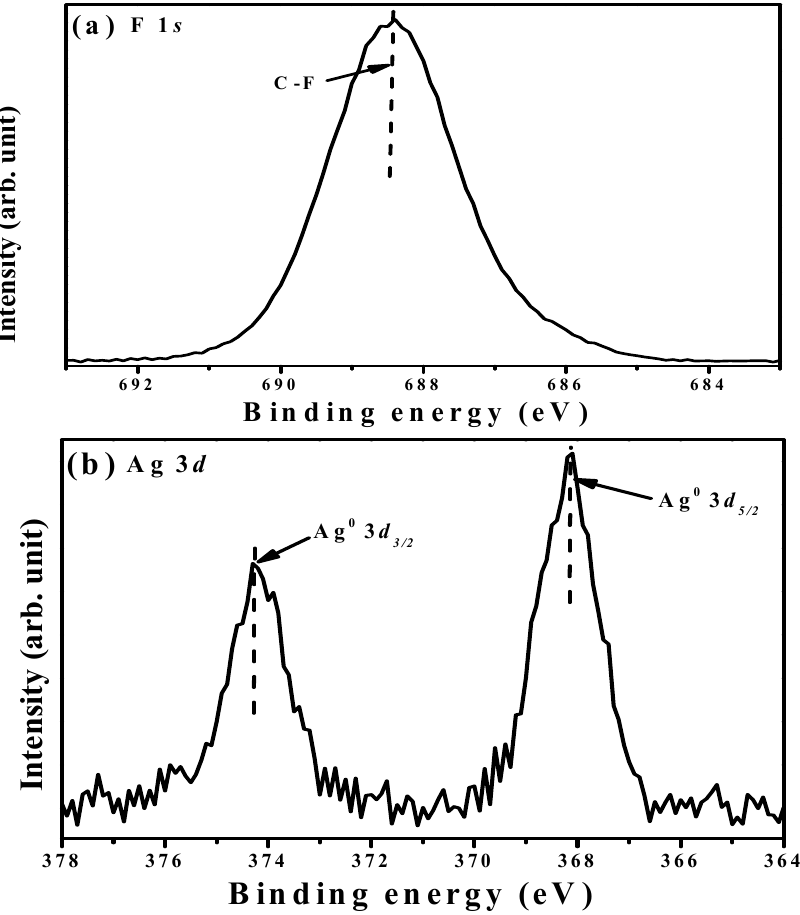
Figure 13. XPS spectra of the ( a ) F 2 s and ( b ) Ag 3 d core levels for the organosilicon films etched by the CF 4 plasma.